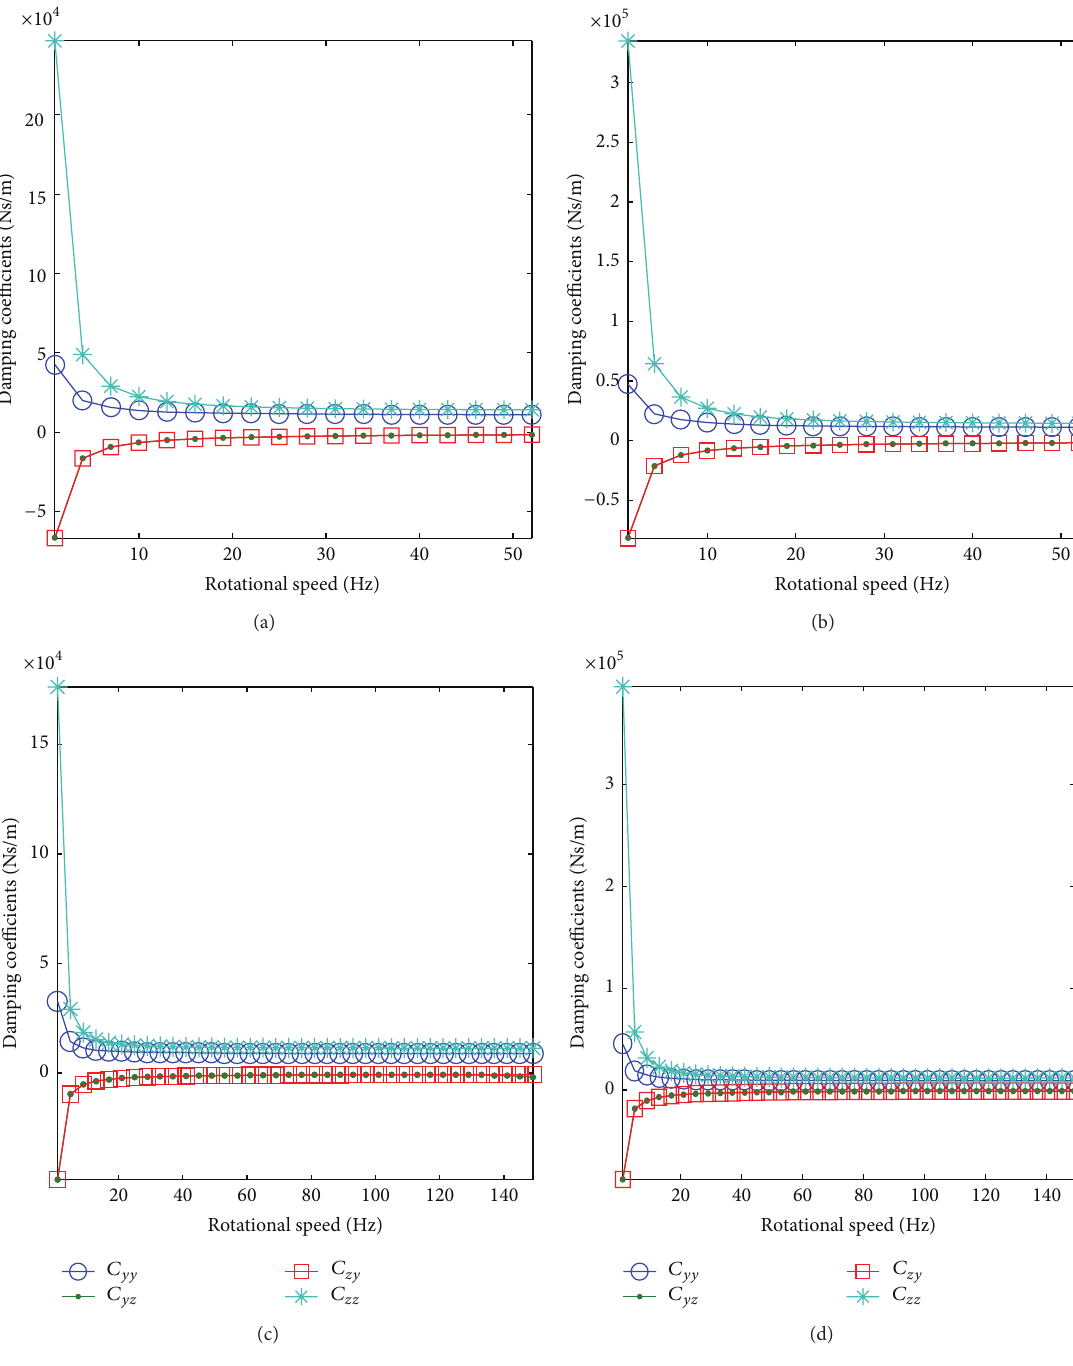
Figure 4: Equivalent coefficients of damping for the journal bearings: (a) bearing 1 in configuration A; (b) bearing 2 in configuration A; (c) bearing 1 in configuration B; (d) bearing 2 in configuration